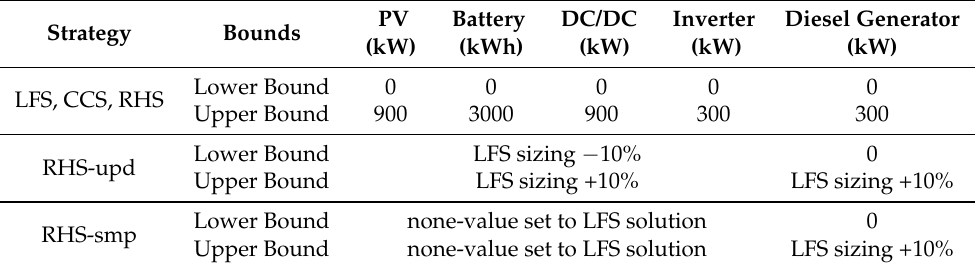
Table 1. Boundaries of the search space used for the heuristic optimization methods. Strategy